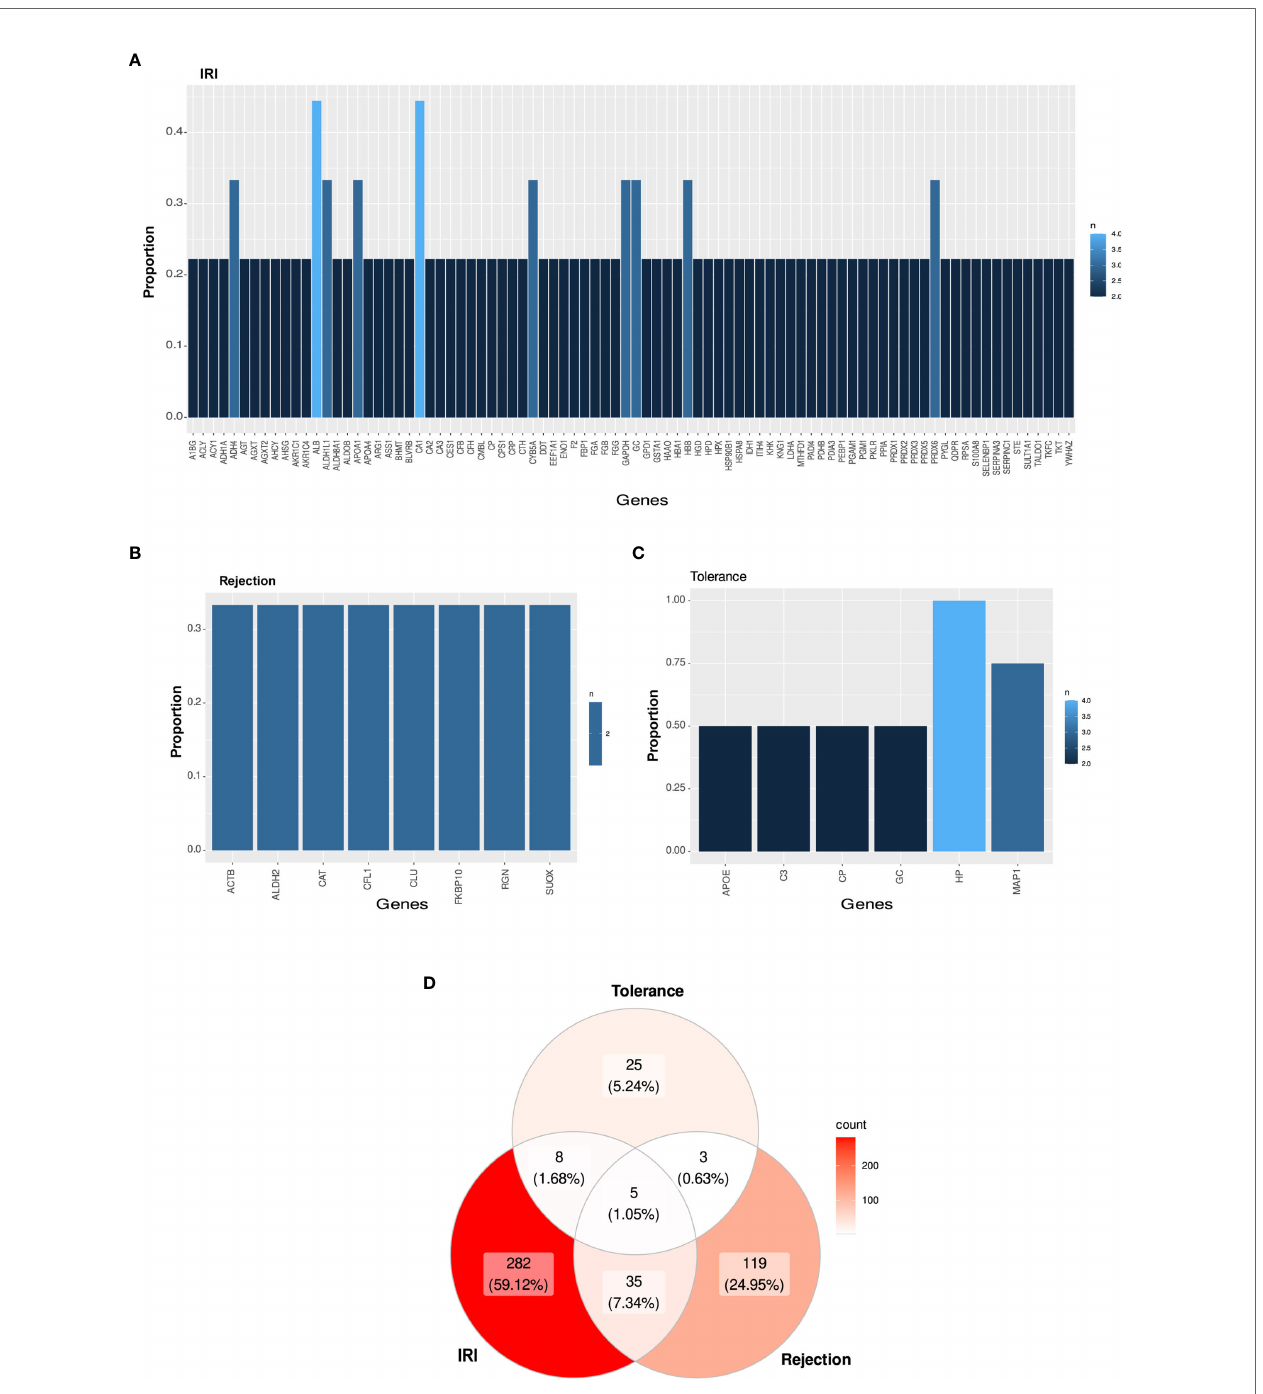
FIGURE 3 | Candidate protein biomarkers from different types of study. (A – C) Bar graph representing the most shared proteins among all selected studies in IRI (A) , rejection (B) or tolerance (C) . (D) Venn diagram among all selected publications in cross-type of study